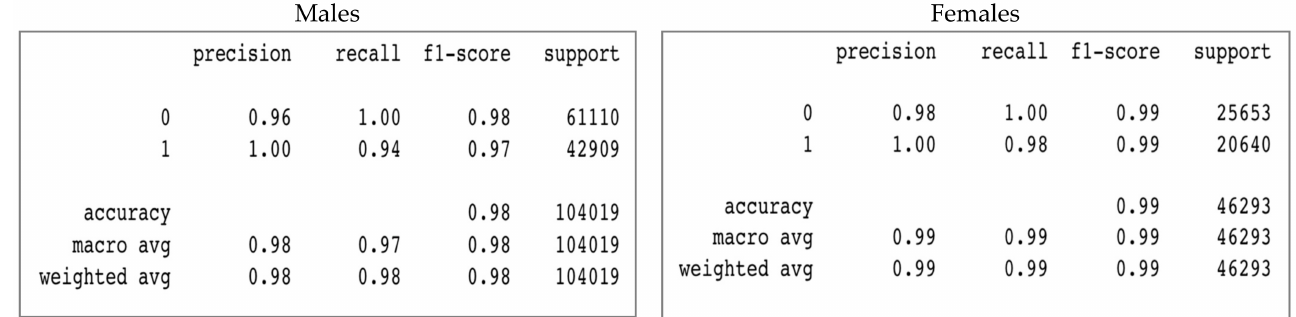
Figure 8. Classification reports for ResNet50’s experiment 1.